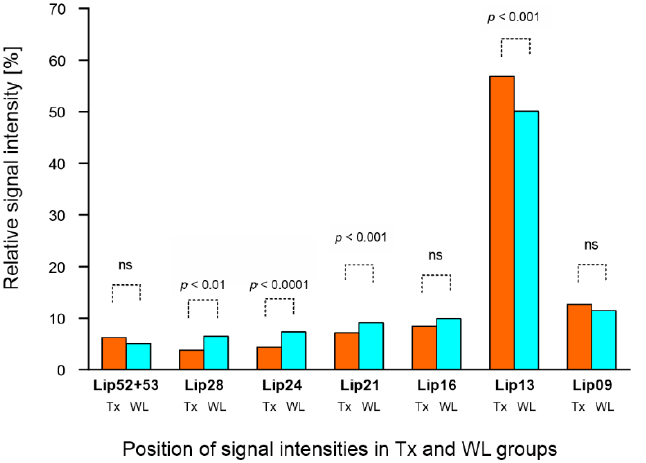
Figure 2. MR metabolic profiles of lipids in liver transplant recipient (Tx) and candidate (WL) groups independent of steatosis grade. Relative signal intensities (in [%]) of liver fatty acids were obtained from spectra with water suppression within chemical shift ranges of 0–3 ppm and 5.2–5.3 ppm.